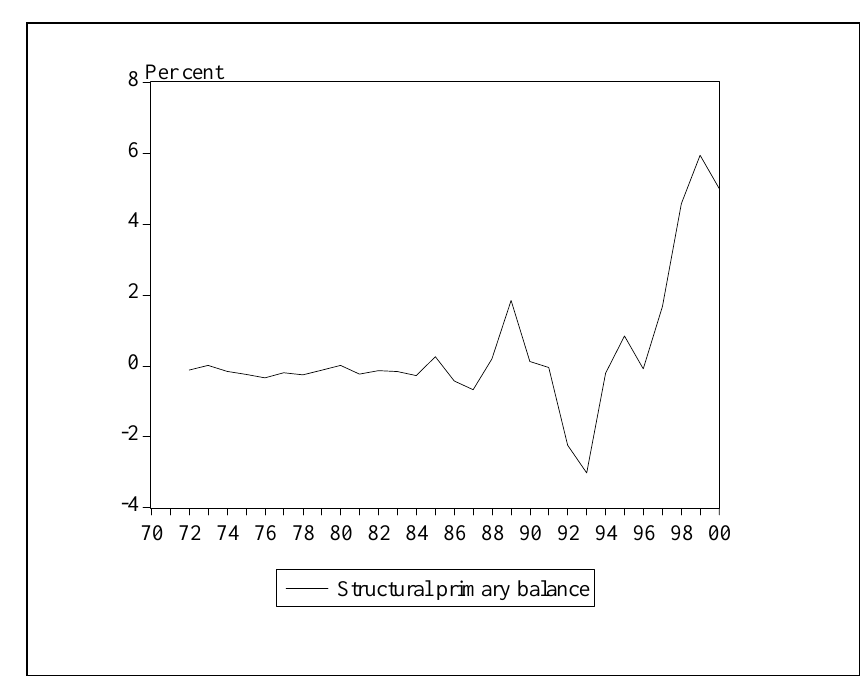
Structural primary balance as a ratio of trend output -4-202468 Per